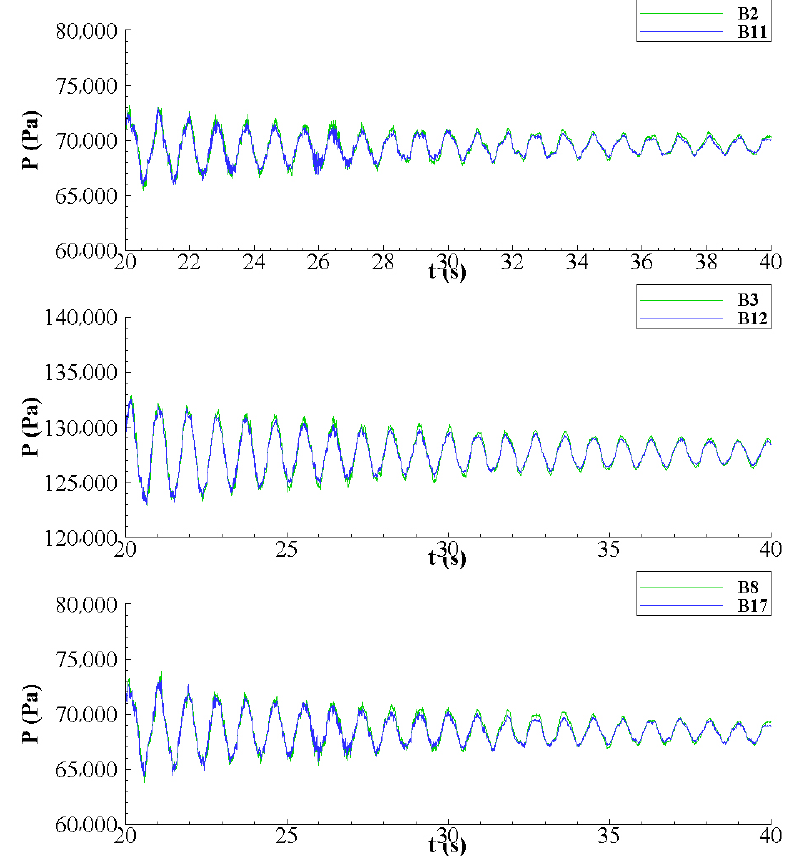
Figure 14. Comparison of pressure evolution at the symmetrical boundary points. (El Centro vertical excitation).